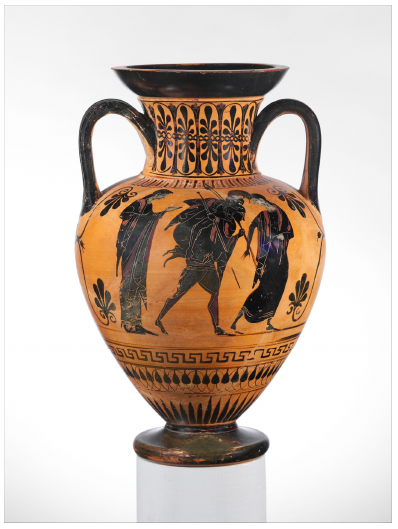
Figure 1. Aeneas carrying his father, Anchises. Attic black-figure amphora, last quarter of